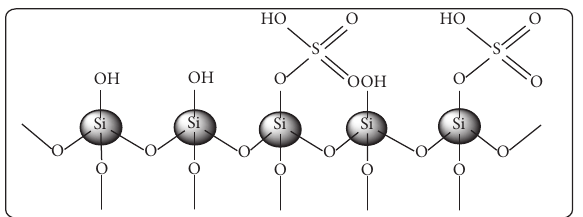
Figure 3: Proposed structure of the Si-H + Table 8: Characteristic FTIR absorption bands of silica-supported acid catalysts.